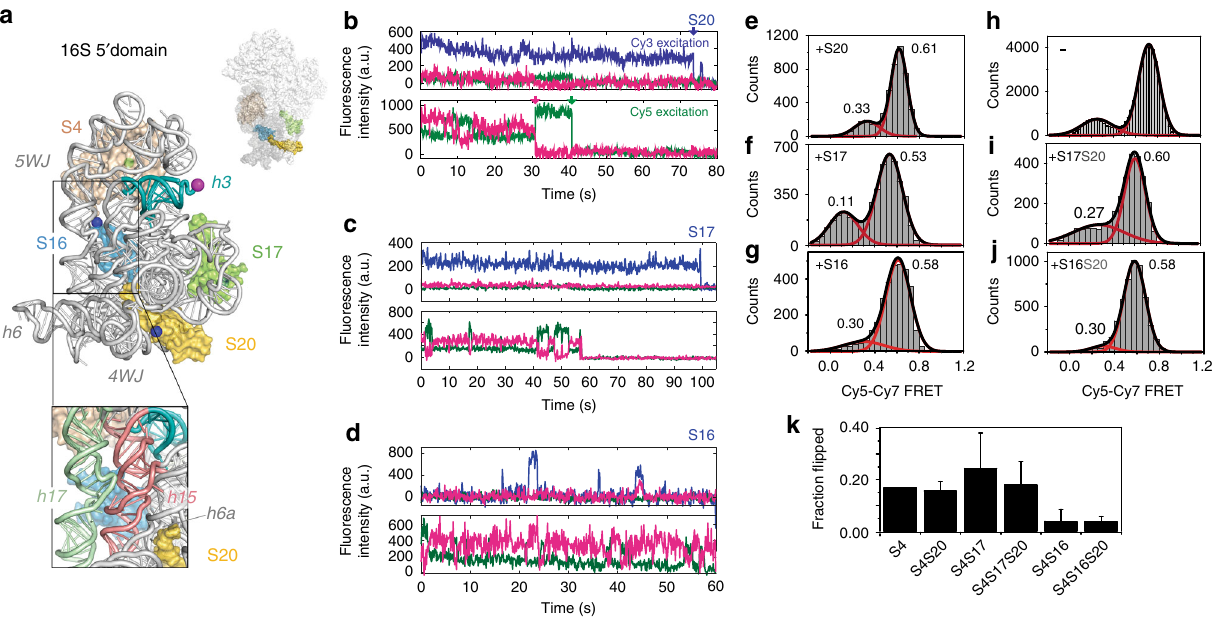
Fig. 1 Ribosomal proteins change the preference for rRNA conformations. a E. coli 16S 5 ′ domain RNA ( gray ribbon, main panel) forms the 30S body (small surface; PDB accession 2I2P 46 ) and binds three primary assembly proteins (S4, S17, and S20) and secondary assembly protein S16. The RNA was fl uorescently labeled with Cy7 ( magenta sphere ) by extension of helix 3 (h3; teal). S4 ( tan surface ) was labeled with Cy5 ( green sphere ). Proteins S16, S17, and S20 were labeled with Cy3 ( blue spheres ). RNA – protein complexes were excited by alternating 532 nm and 633 nm laser pulses using a custom-built multi-color single molecule FRET microscope 51 . Inset : expansion of S16 binding site showing h15 ( light red ) and h17 ( light green ). b – d Representative fl uorescence traces obtained from complexes of 5 ′ domain RNA (h3-Cy7) and S4-Cy5 with S20-Cy3 b , S17-Cy3 c , or S16-Cy3 d . Cy3, blue ; Cy5, green ; Cy7, magenta . Single-step photobleaching events for each dye ( colored arrows ) indicate 1:1:1 stoichiometry between the components. S16-Cy3 exhibits high FRET ef fi ciency to S4-Cy5 and h3-Cy7 upon speci fi c binding to the complex (at 43 s in d ). e – j . Histograms of FRET between S4-Cy5 and h3-Cy7 in the presence of the additional proteins in e – g , i and j were obtained from 110, 50, 30, 20, and 37 individual complexes, respectively. The Cy3 intensity was used to verify the presence of S20-Cy3, S16-Cy3 and S17-Cy3 e – g ; the presence of unlabeled S20 i , j was inferred from the frequency of S20-Cy3 binding in b . Data in h are from Ref. 12 and represent Cy3-Cy5 FRET. k Population of the fl ipped conformation (low FRET) from the histograms in e – j . Error bars represent the